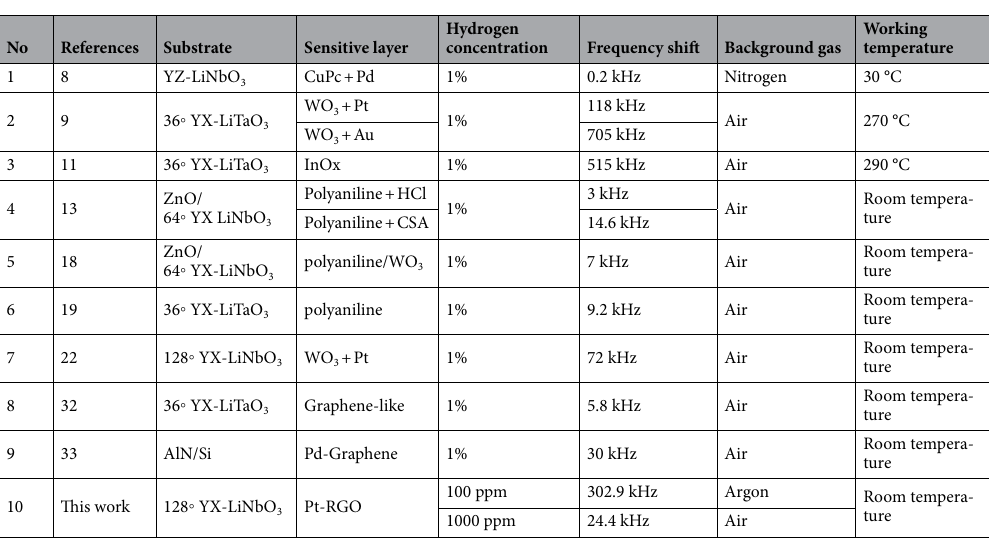
Table 1. Performance of ultrasonic H 2